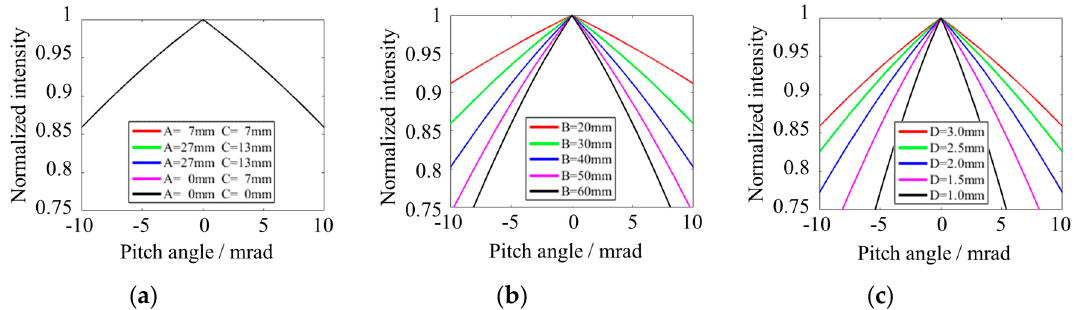
Figure 8. The relationship between the normalized intensity and pitch angle with different structure parameters. ( a ) Rotation arms are changed. ( b ) Lengths of the diffracted beams are changed. ( c ) Beam diameters are